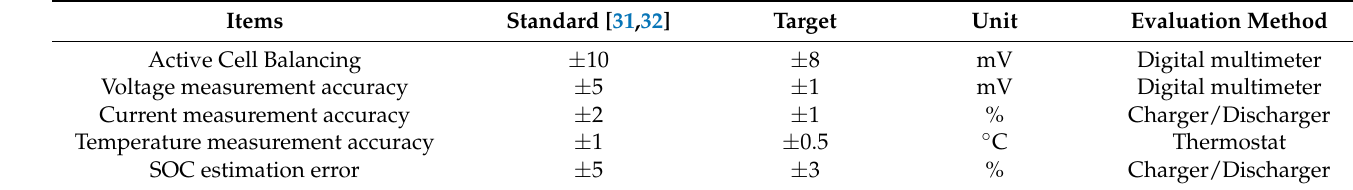
Table 2. Design targets of the smart BMS.